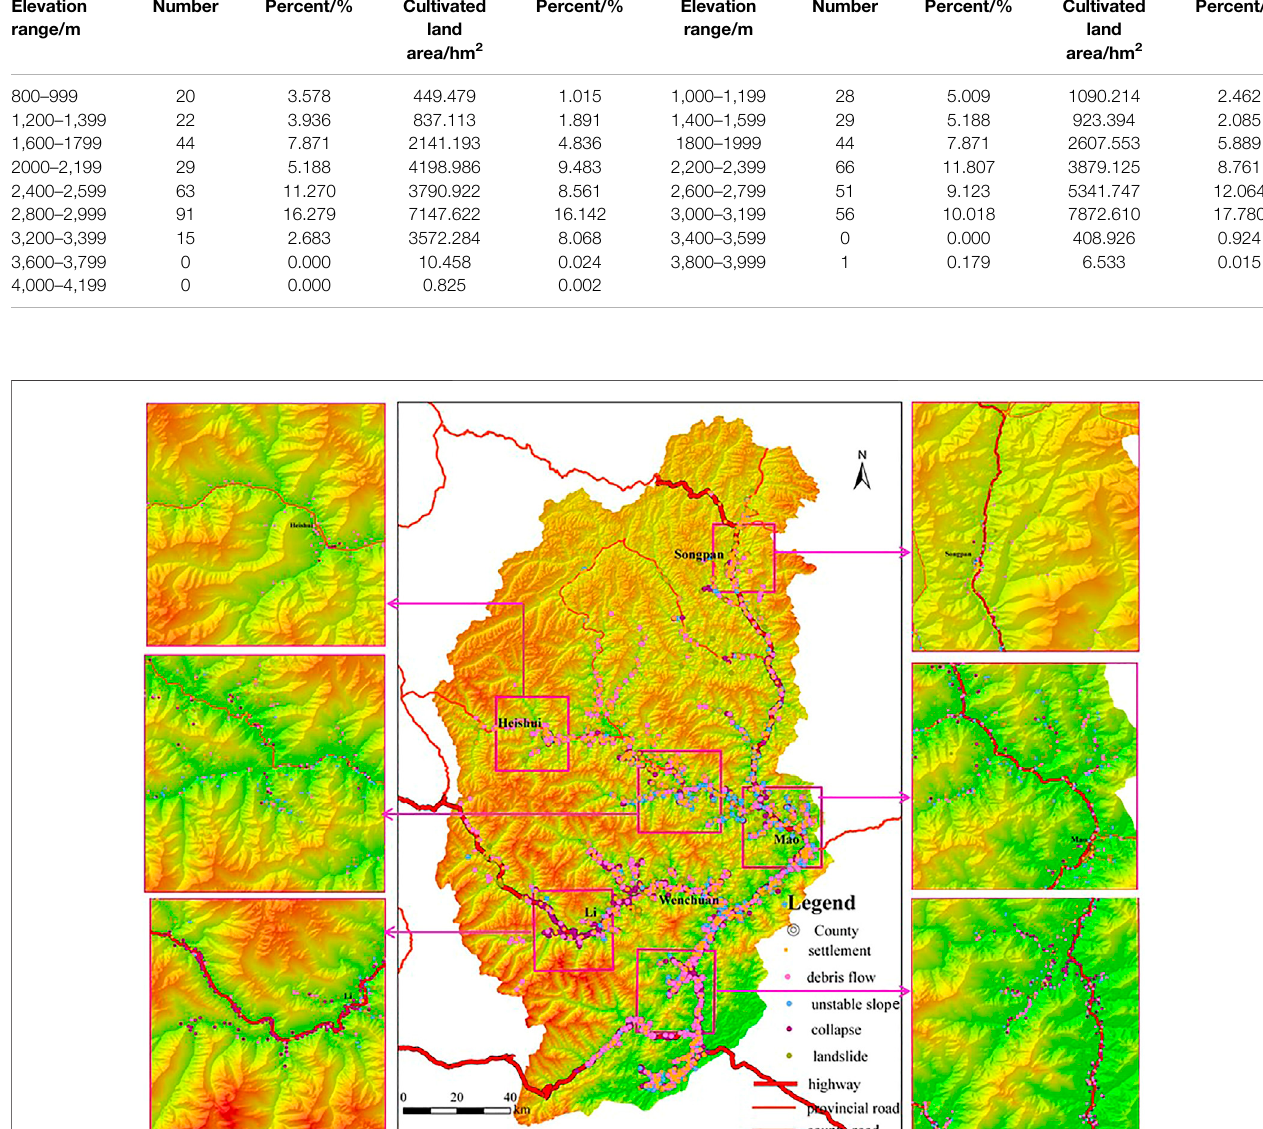
Frontiers in Earth Science |